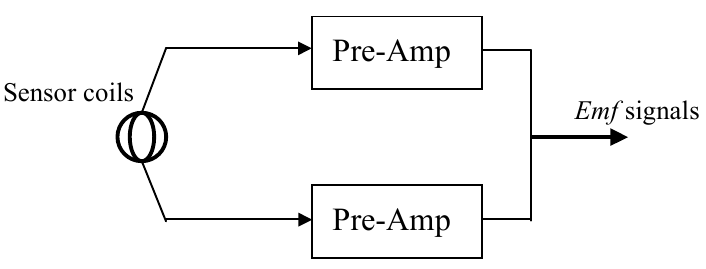
Figure 12. The block diagram of the sensor module. Sensor coils